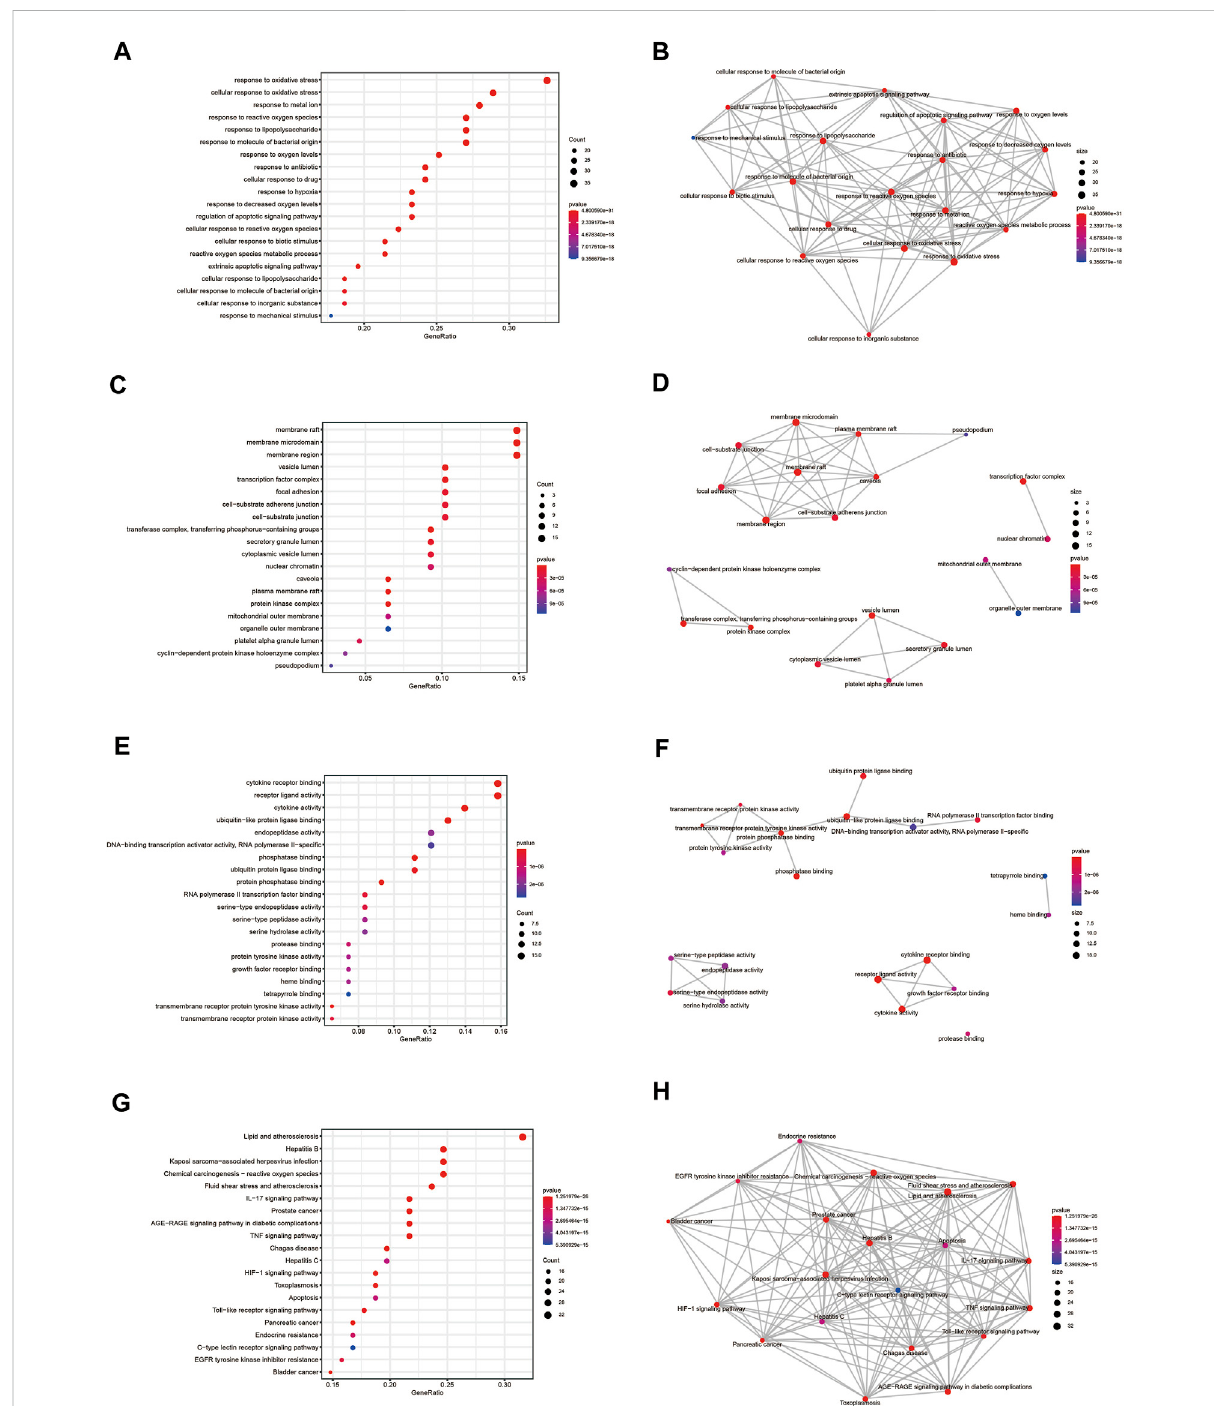
FIGURE 8 GO and KEGG enrichment analysis. (A, B) Outcomes of BP enrichment analysis and correlation analysis. (C, D) Outcomes of CC enrichment analysis and correlation analysis. (E, F) Outcomes of MF enrichment analysis and correlation analysis. (G, H) Outcomes of KEGG enrichment analysis and correlation analysis. GO: Gene ontology; KEGG: Kyoto Encyclopedia of Genes and Genomes; BP: biological processes; CC: cellular components; MF: molecular